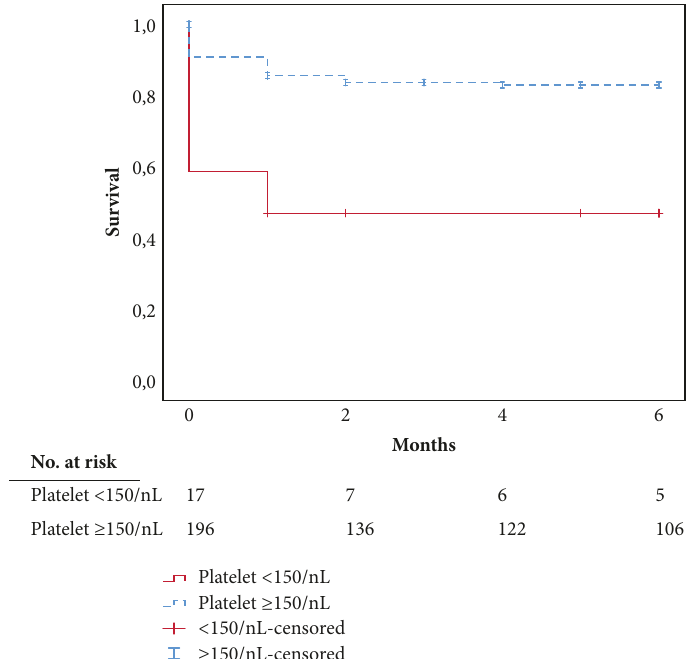
Figure 1: Six-month patient survival plot: significantly lower survival rates in patients with low preoperative platelet counts ( < 150 x 10 9 /L) compared with normal preoperative platelet counts ( ≥ 150) (log-rank test p <